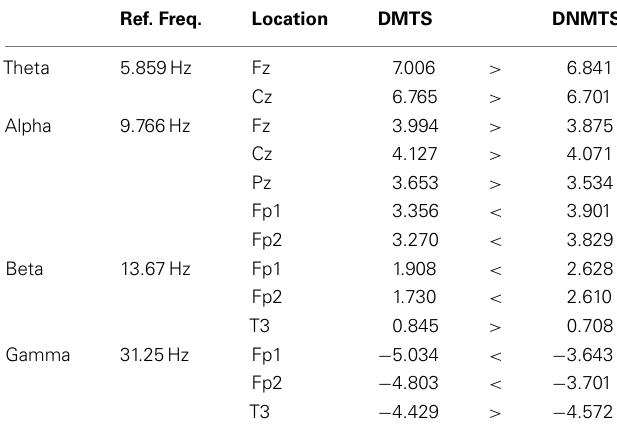
Table 1 | Mean ± SEM scores according to task condition and sample stimulus category.